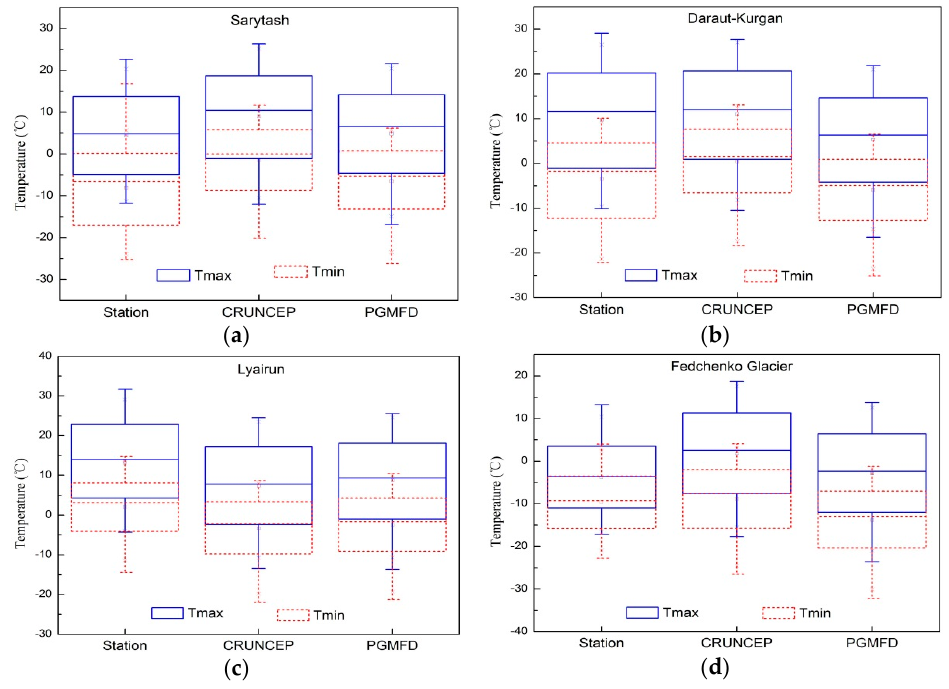
Figure 5. Box plots of temperature based on WSD and gridded data sets at four stations. ( a ) box plot of temperature at Sarytash station; ( b ) box plot of temperature at Daraut ‐ Kurgan station; ( c ) box plot of temperature at Lyairun station ( d ) box plot of temperature at Fedchenko Glacier station.